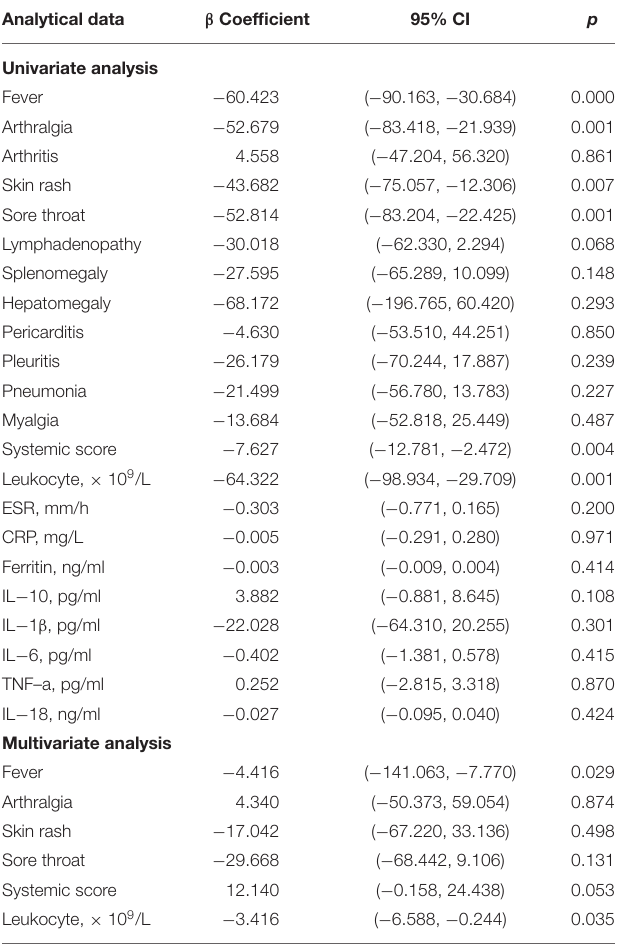
TABLE 2 | Linear regression models to explore a specific clinical or laboratory item associated with Cyr61. Analytical